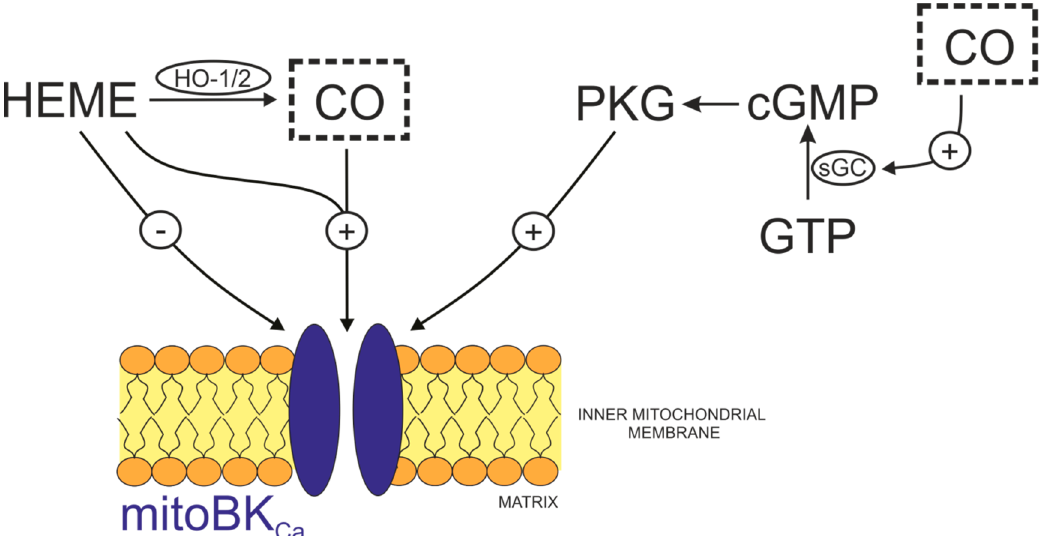
Figure 1. Regulation of the mitochondrial large-conductance calcium-activated potassium channel (mitoBK Ca ) activity by CO. The activity of the channel is inhibited ( − ) by heme alone but could be stimulated (+) in the presence of heme (HEME, Fe-protoporphyrin IX) and CO (gasotransmitter shown in the dotted box) (a product of the activity of HOs). Independently, CO stimulates sGC/cGMP/PKG pathway leading to channel phosphorylation and activation. Abbreviations: CO, carbon monoxide; HO, heme oxygenase; PKG, cGMP-dependent protein kinase; sGC, soluble guanylate cyclase.